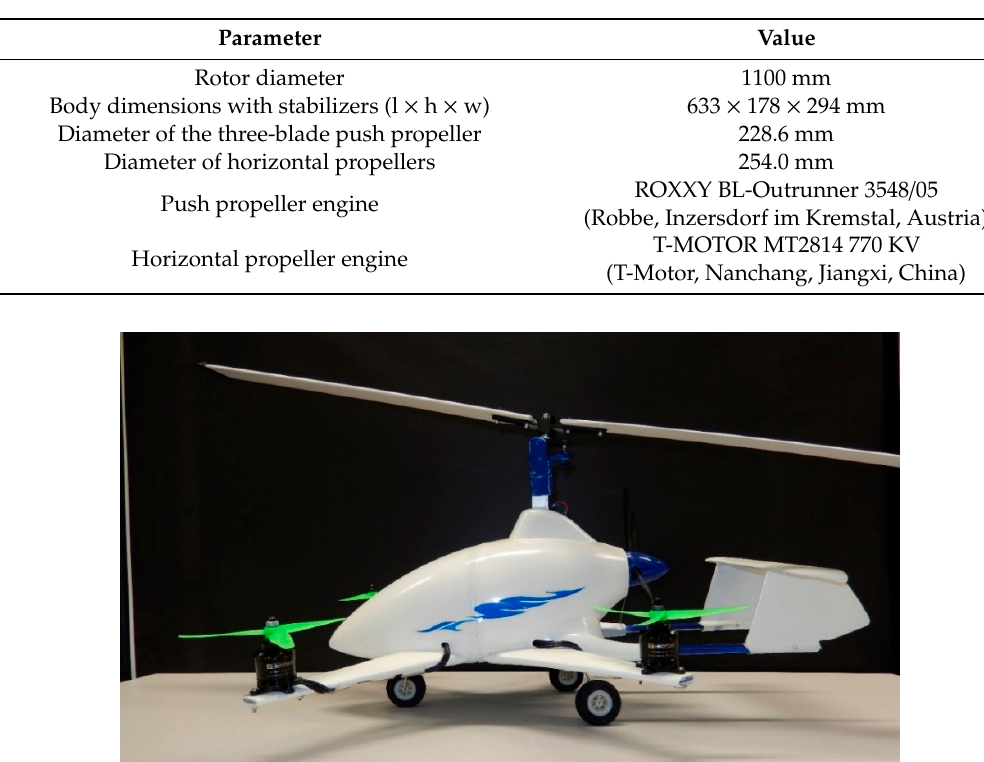
Figure 2. View of the model of the tested multirotor aircraft.